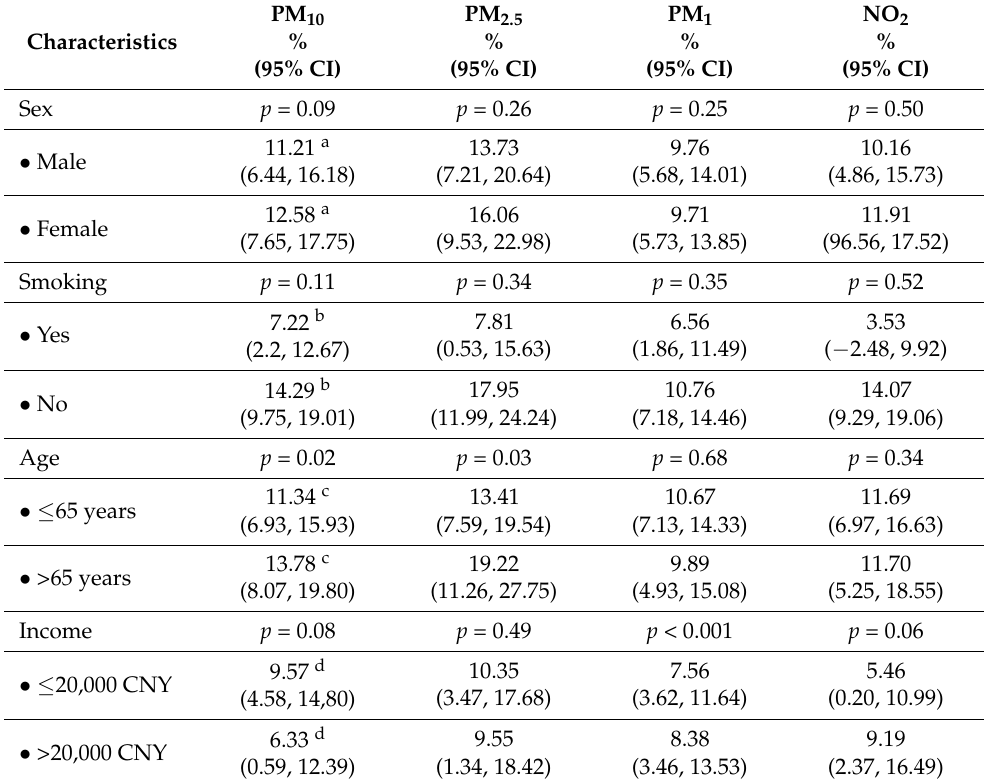
Table 2. Stratified analysis of percentage change in hs-CRP level with 10 µ g/m 3 increase in 3 year moving averages in each pollutant level.